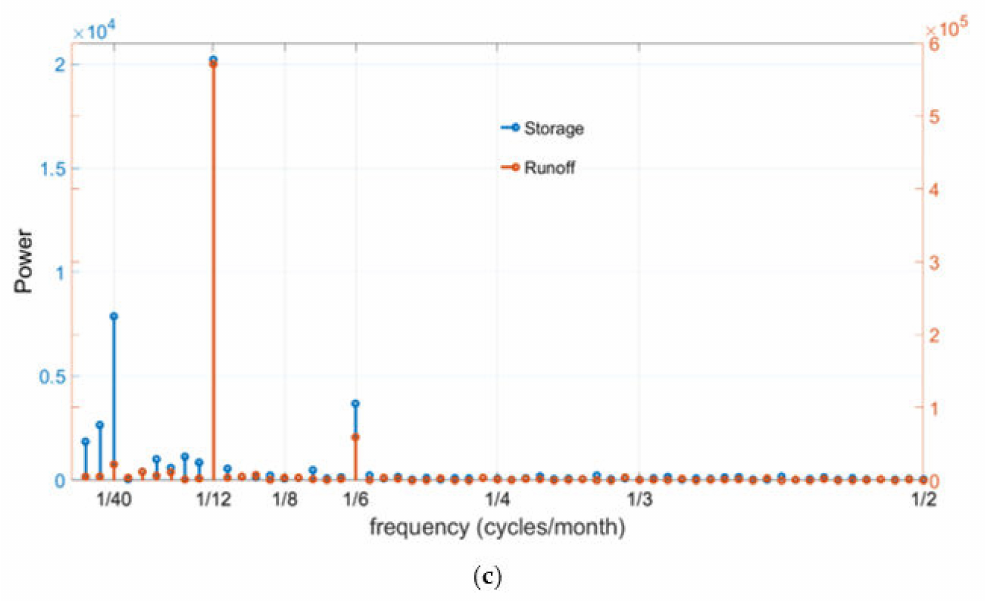
Figure 3. ( a ) Terrestrial water storage anomaly and runo ff time series in Yangtze River Source Region from 2003 to 2012, ( b ) Runo ff -Storage year-by-year with correlation coe ffi cient calculated from after detrending, and ( c ) Power spectrum of TWSA and runo ff time series via fast Fourier